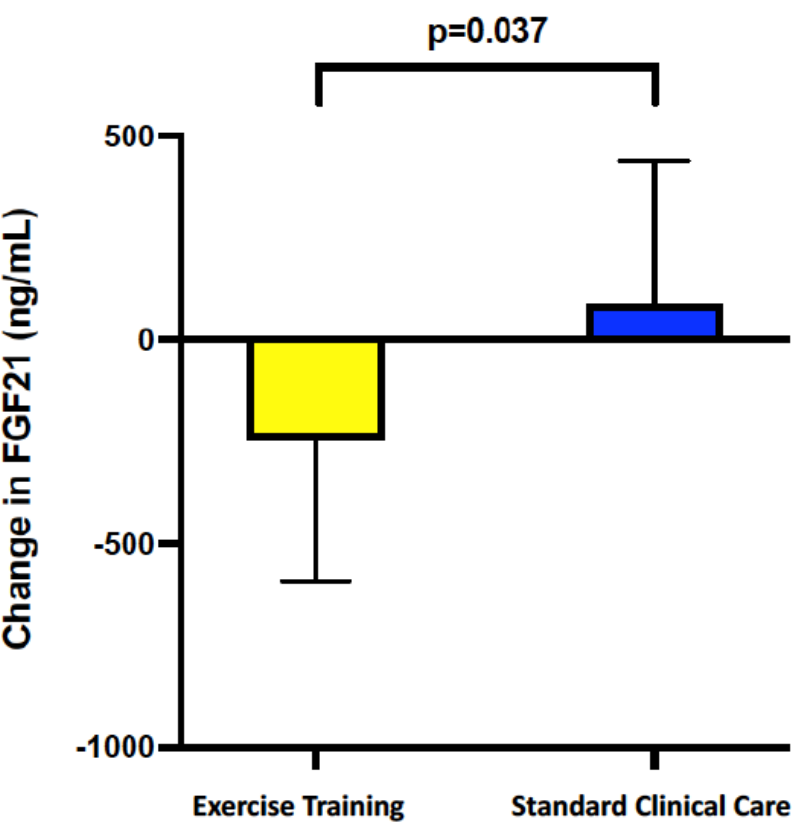
Figure 1. Change in serum FGF21 comparing exercise training to standard clinical care. Serum FGF21 was reduced by 22% ( − 243 ng/mL) following exercise training, whereas standard clinical care patients had an increase of 34% (+88 ng/mL).